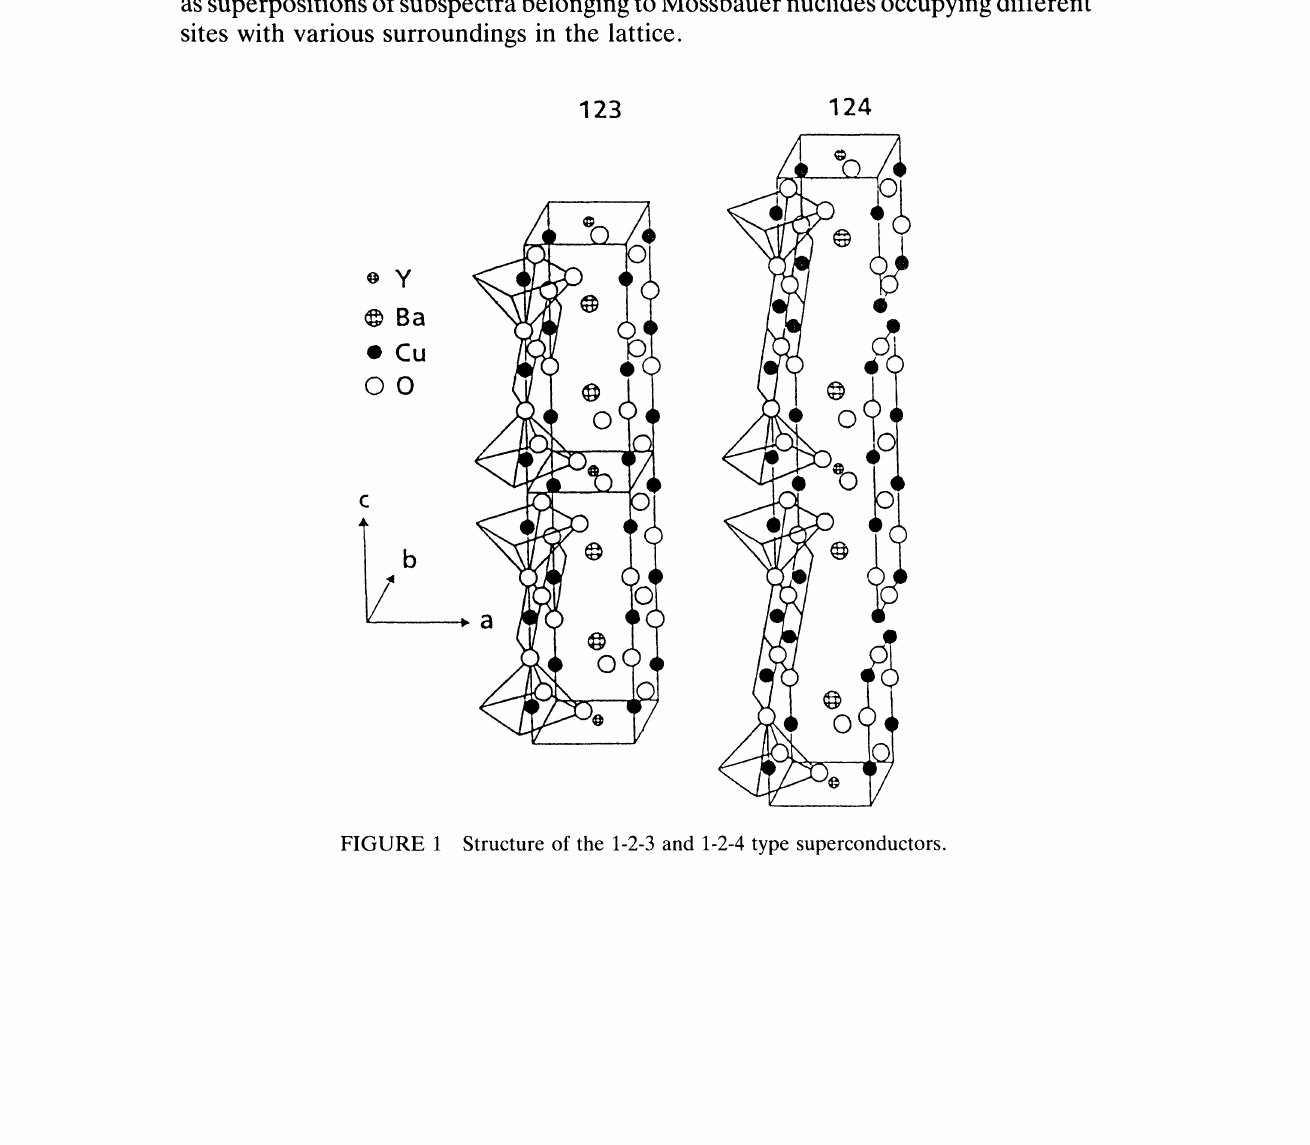
FIGURE Structure of the 1-2-3 and 1-2-4 type